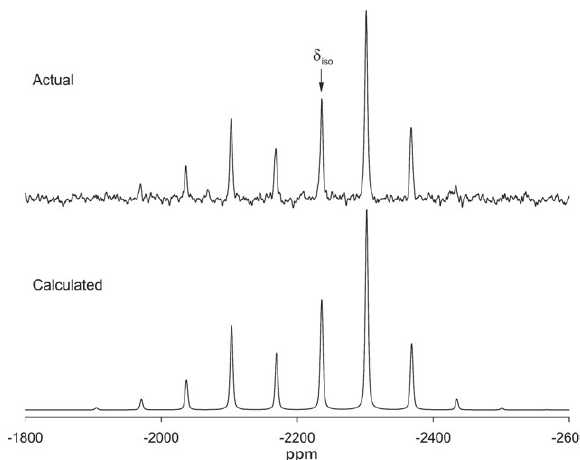
Figure 2 Experimental and iteratively fitted 119 Sn MAS NMR spectrum (spinning frequency, 9.86 kHz) of (Cp*Sn)BPh = -2236 is indicated with an arrow. centre peak δ iso